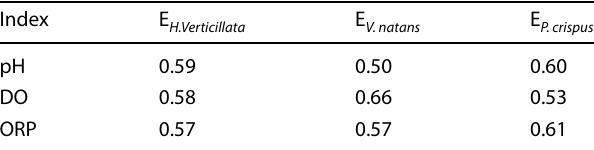
Table 2 Principal component eigenvectors of the environmental factors of the three treatment